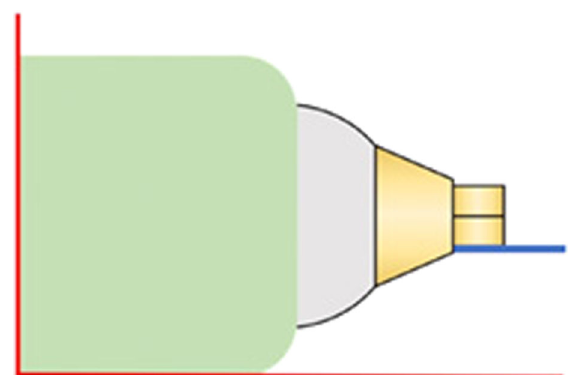
Fig. 4 Specimen in putty mold (green), side view. Red lines representing fl at surfaces at right angle to each other, blue line representing one hexagonal side parallel to fl at surface (red line).